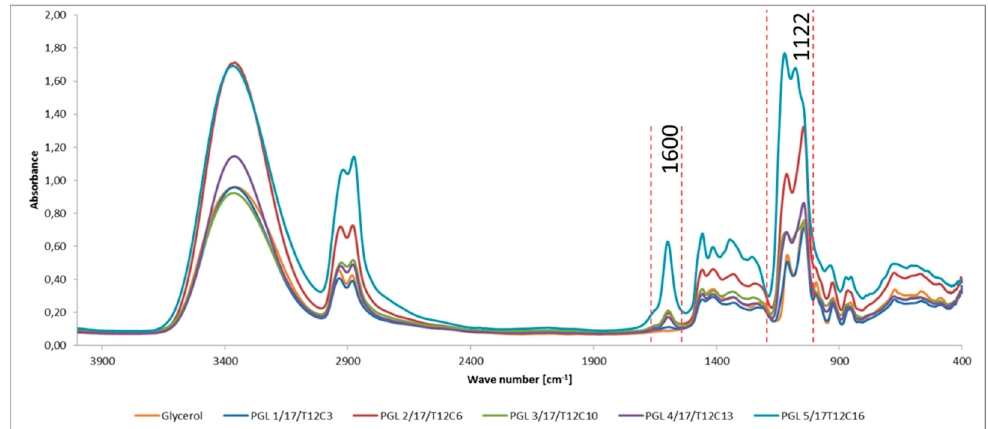
Figure 9. FTIR spectra (film between KBr) for the glycerol oligomerization products. The spectrum for the raw material (glycerol) was also presented for reference .